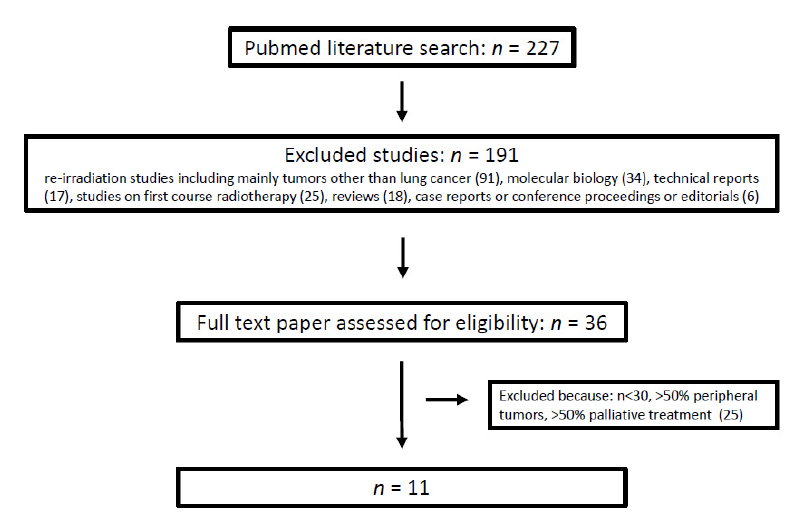
Figure 1. Study selection process.(This review was not registered with PROSPERO).